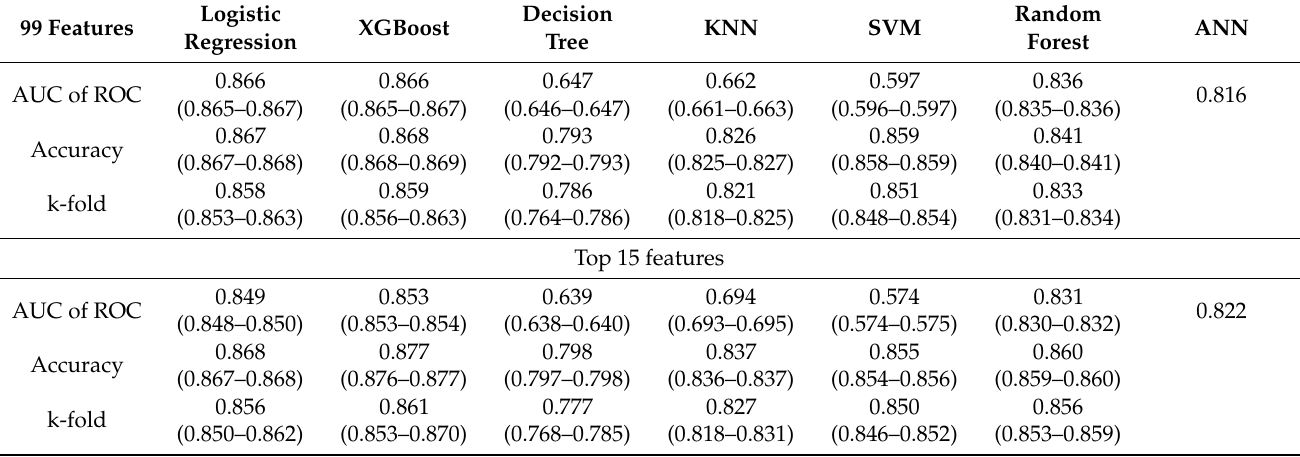
Table 3. The area under the curve (AUC) of the receiver operating characteristic (ROC) curve, accu- racy, and k-fold of prediction models generated from machine-learning algorithms in the An- san/Ansung cohort.